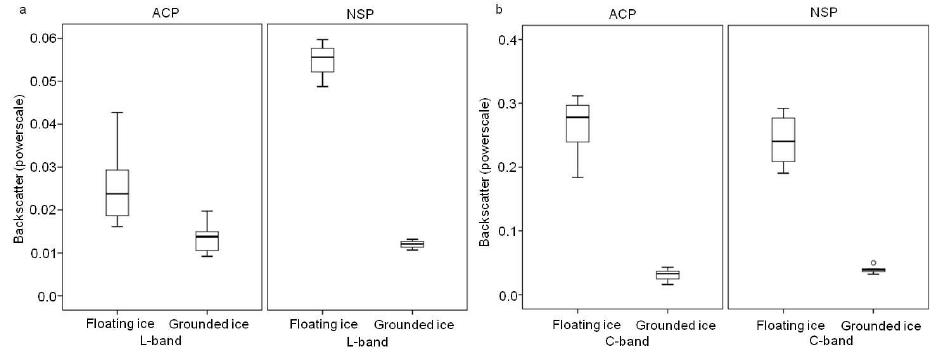
Fig. 3. Boxplots of mean backscatter intensity of all floating and grounded ice from study lakes for each SAR scene from (a) L-band and (b) C-band. No statistical far-outliers and only one near outlier (panel a NSP, ERS-1, 30 April 1993) indicate that SAR backscatter values from floating and grounded ice in late March-April are similar from year to year. Note different scales on y axis for (a) and (b).